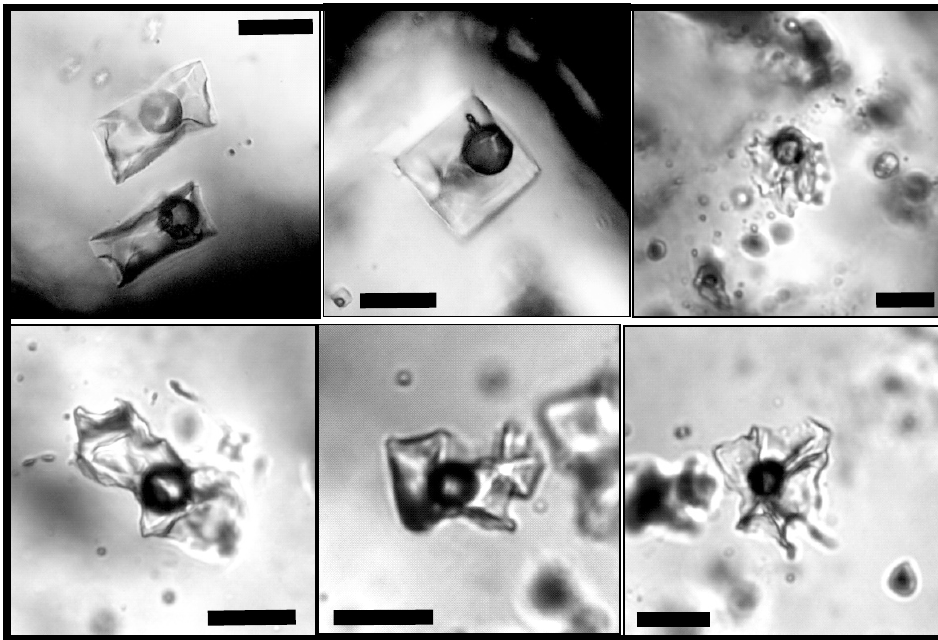
Figure 8. Primary fluid inclusions of homogeneous capture in quartz from quartz-molybdenite veinlets of the Pervomaiskoe deposit. The length of the scalebar—10 microns.